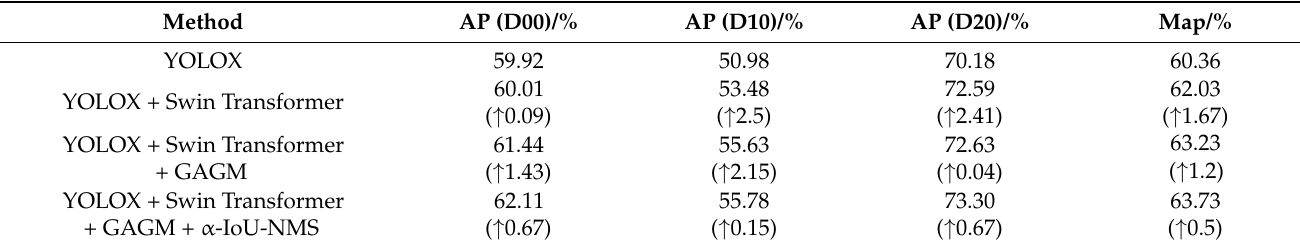
Table 3. Comparison results of the ablation experiments.